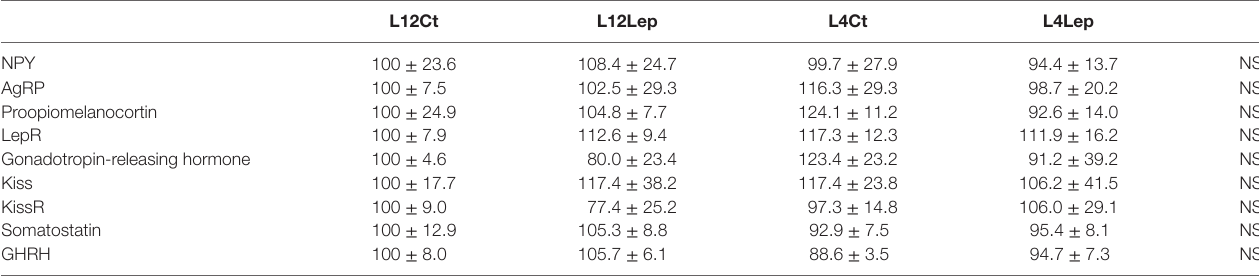
TaBle 2 | Relative levels of mRNA of selected genes in the hypothalamus of male peripubertal rats from litters of 12 (L12) or litters of 4 (L4) pups that were treated with vehicle (control, CT) or leptin (Lep) and sacrificed 2 h later.